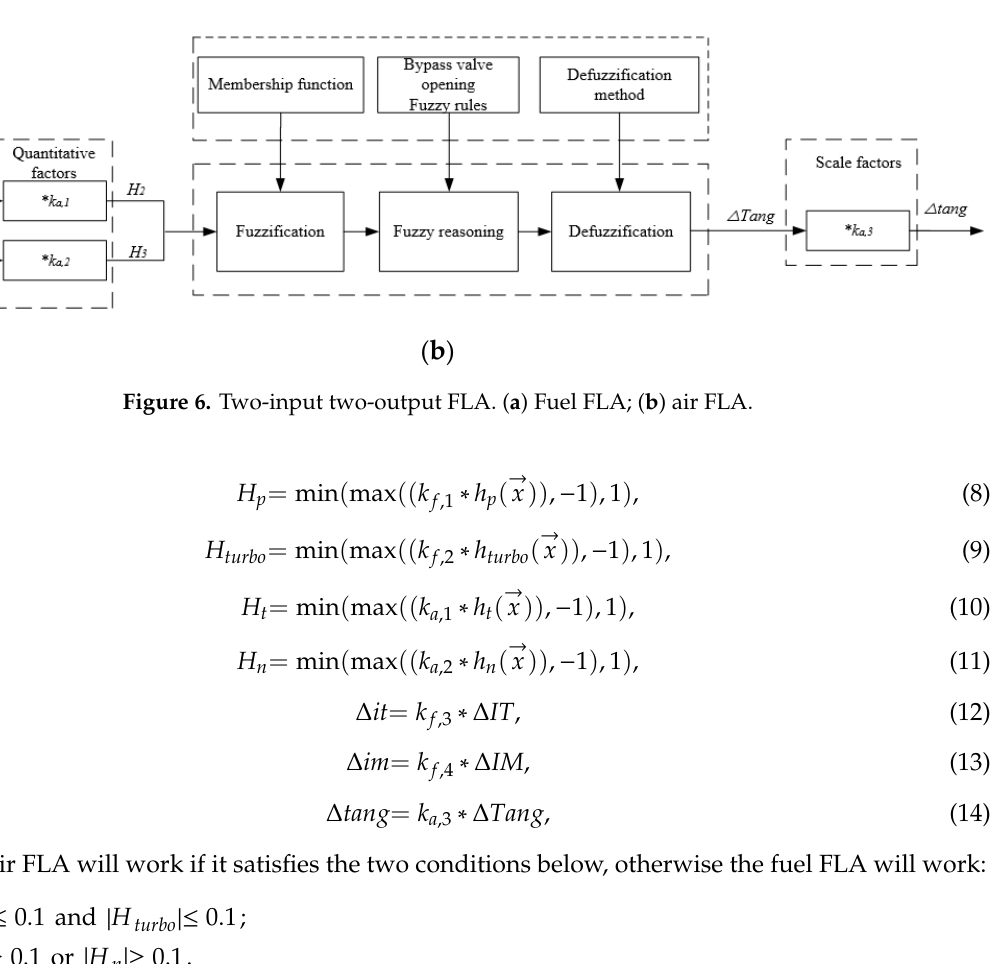
Figure 7. Fuzzy set definitions.